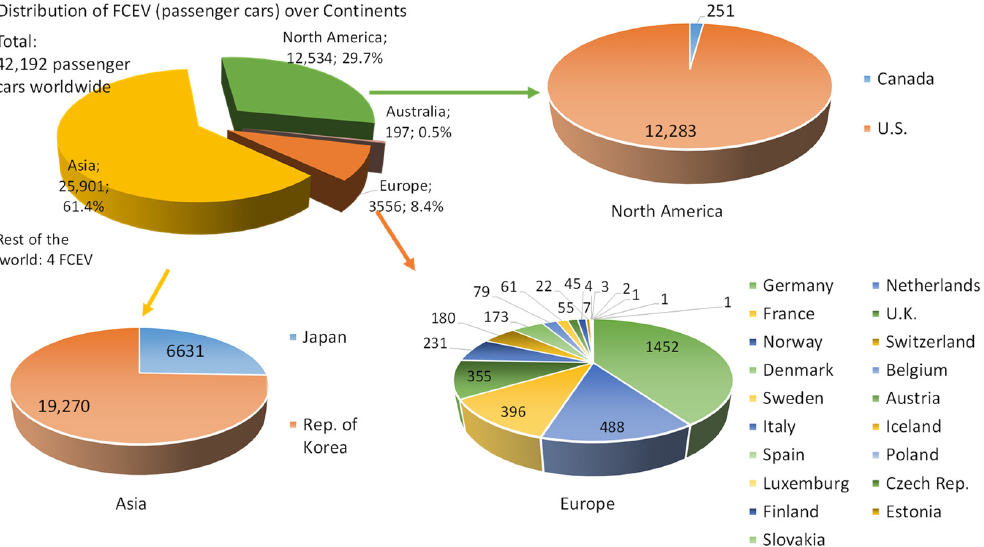
Figure 3. Closer look at the distribution of fuel cell passenger cars to continents and countries.